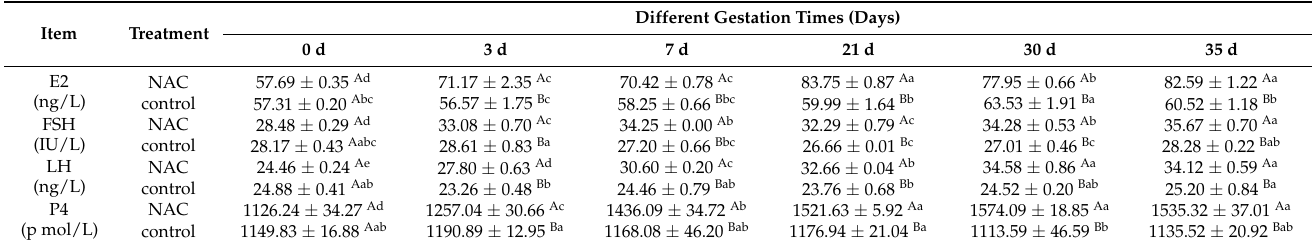
Table 2. Effects of NAC on serum reproductive hormone indices in does at different times of gestation.